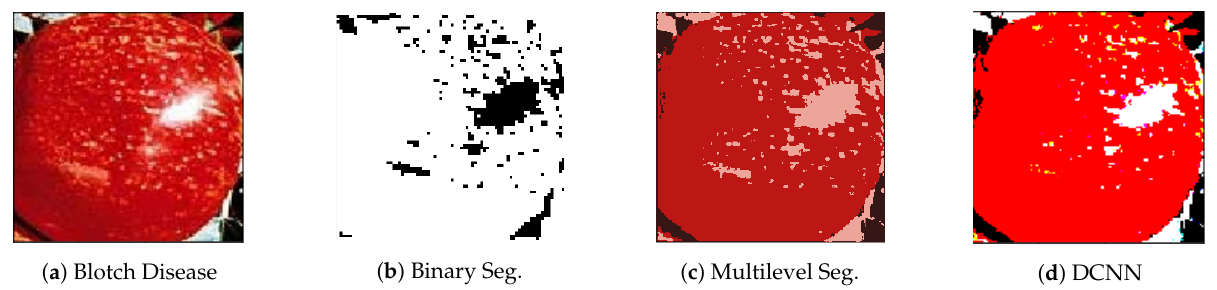
Figure 7. Rot apple process through binary thresholding, clustering and DCNN.